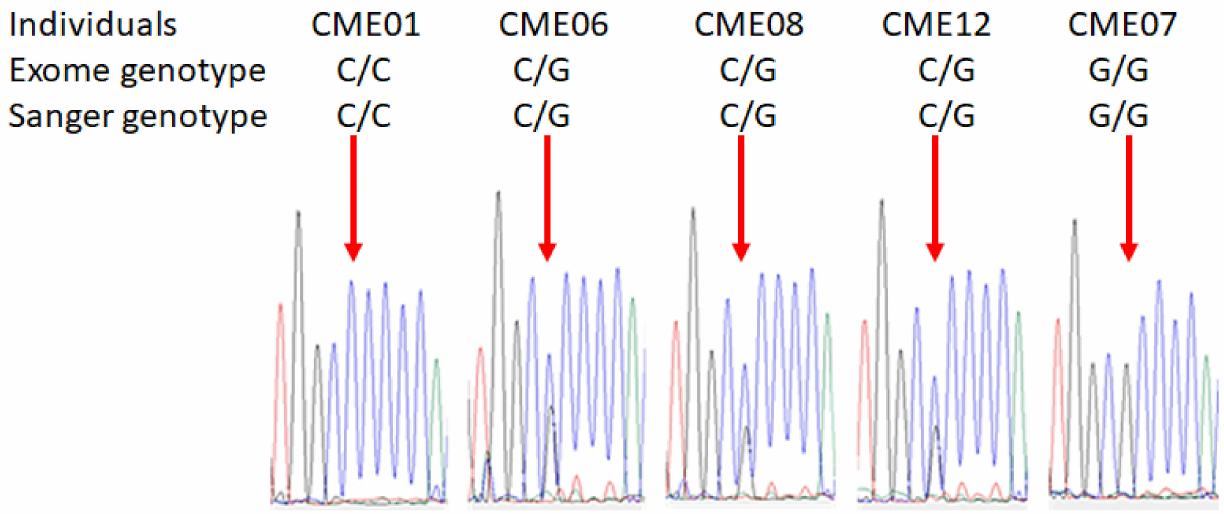
Figure 2. Sanger chromatograms of patients with or without the damaging variant MRPS18B . The confirmatory sequencing was performed by Sanger sequencing. The DNA of each patient was extracted using QIAamp DNA Blood Maxi Kit (Qiagen, Germantown, WI, USA) and 25 ng of DNA was used for the amplification of MRPS18B gene. PCR quality was assessed by gel electrophoresis and all samples generated a single band corresponding to MRPS18B. Then, samples were sequenced by Sanger sequencing by Genewiz. Representative images of Sanger chromatograms of the 5 patients reveal the change in the nucleotide. The red arrow indicates the base change from cytosine to